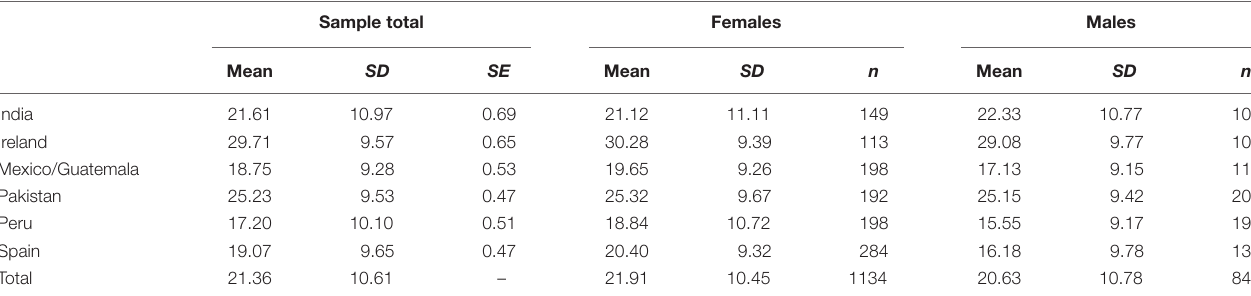
TABLE 9 | Mean and SD by